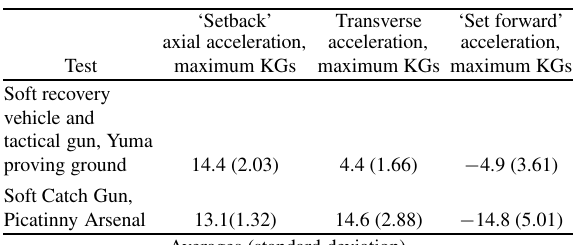
Table 1 Soft Catch Gun system, Picatinny Arsenal